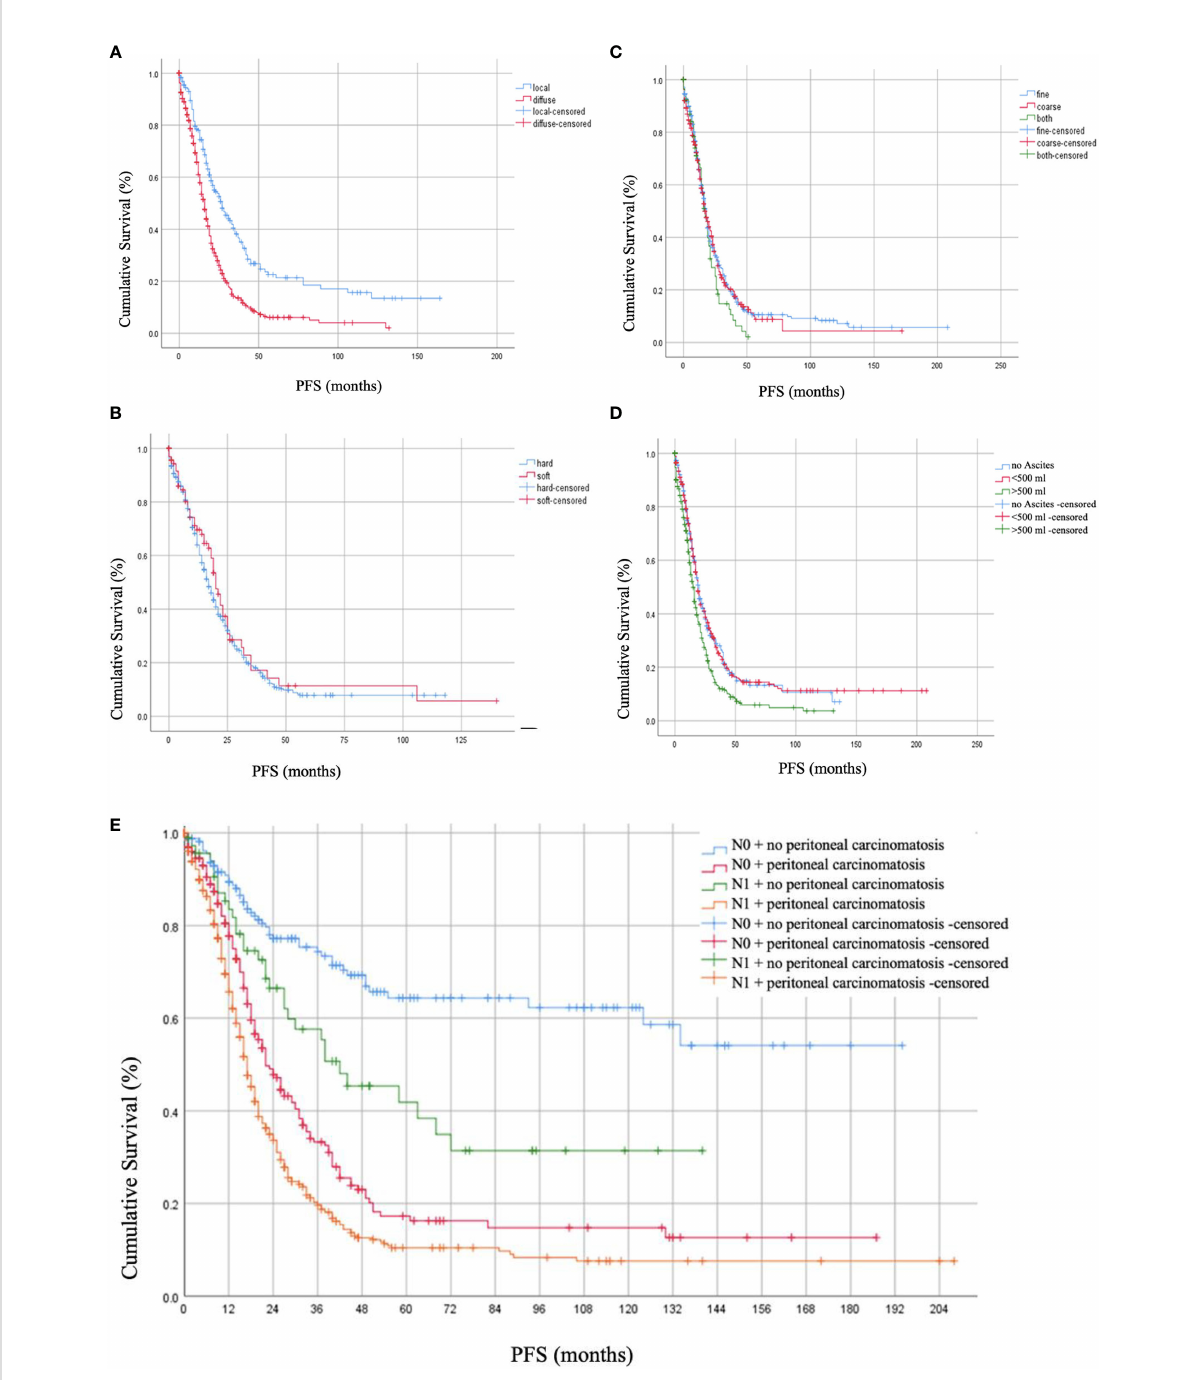
FIGURE 2 Progression-free Survival (PFS) rates in months based on (A) localization of peritoneal carcinomatosis, (B) consistency of peritoneal carcinomatosis, (C) texture of peritoneal carcinomatosis nodules, (D) presence of ascites together with peritoneal carcinomatosis, and (E) lymph node